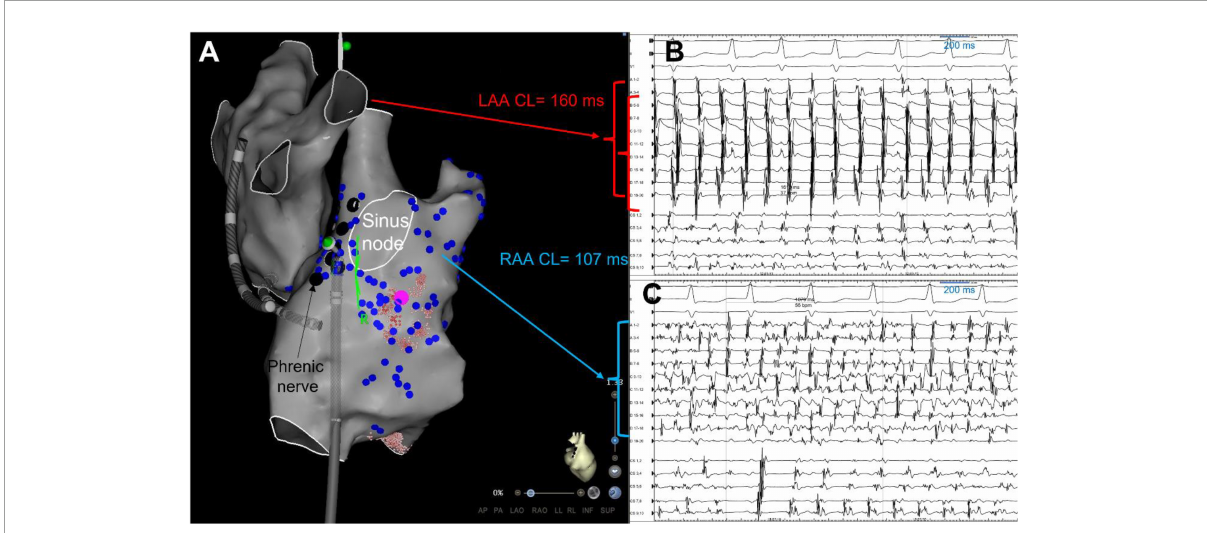
FIGURE1 Right atrial appendage firing (RAAF) ablation limited by phrenic nerve and sinus node locations. Biatrial 3D shells in the right lateral view (panel A ), in a patient with paroxysmal AF recurrences despite a previous PVI. AF was induced by atrial pacing, PVs were not connected, and biatrial mapping highlighted a rapid driver in the right atria, located at the appendage/lateral wall area (blue dots = dispersion, cycle length = 107 ms – panel B ), while the left atrium was bystander (no dispersion, cycle length = 160 ms – panel C ). Ablation of this driver was limited by the location of the sinus node (white circle) mapped in sinus rhythm and the phrenic nerve (black dots) located by pacing. Sinus rhythm was restored by ablation at this area (pink dot) and AF was not inducible anymore. CL, cycle length, LAA, left atrial appendage, RAA, right atrial